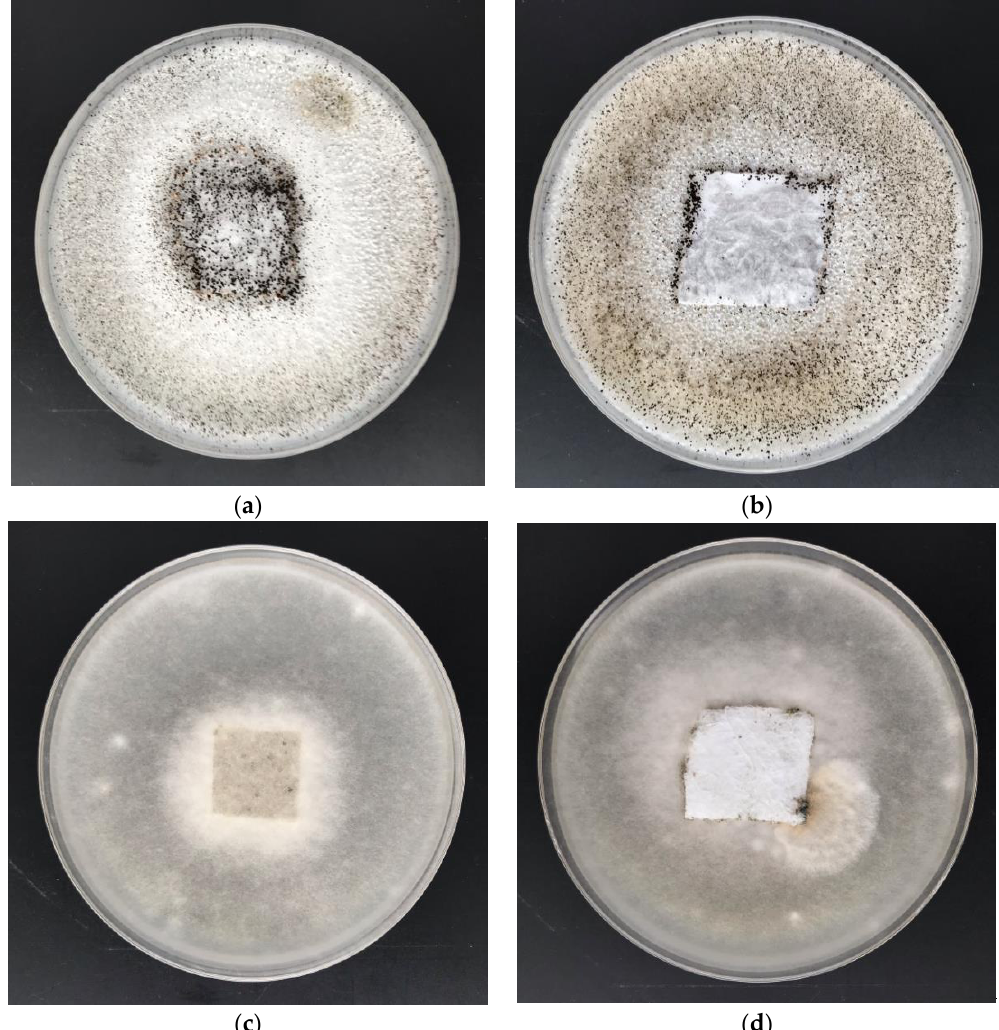
Figure 13. Zone of inhibition test results on Petri dishes showing antifungal activity: ( a , b ) — A. niger ; ( c , d ) — C. globosum ; ( a , c ) — Control: unmodified PLA nonwoven fabric; ( b , d ) — Sample: PLA-ALG-Zn (2+) material.